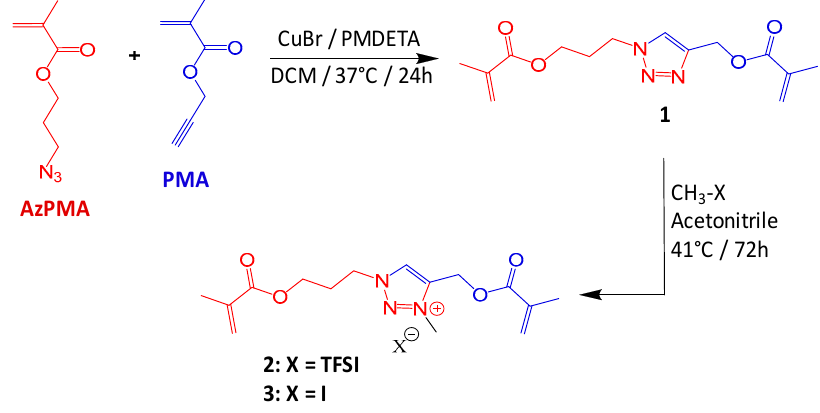
Figure 2. Synthesis of triazole ( 1 ), triazolium + / TFSI − ( 2 ), and triazolium + / I − crosslinker ( 3 ).